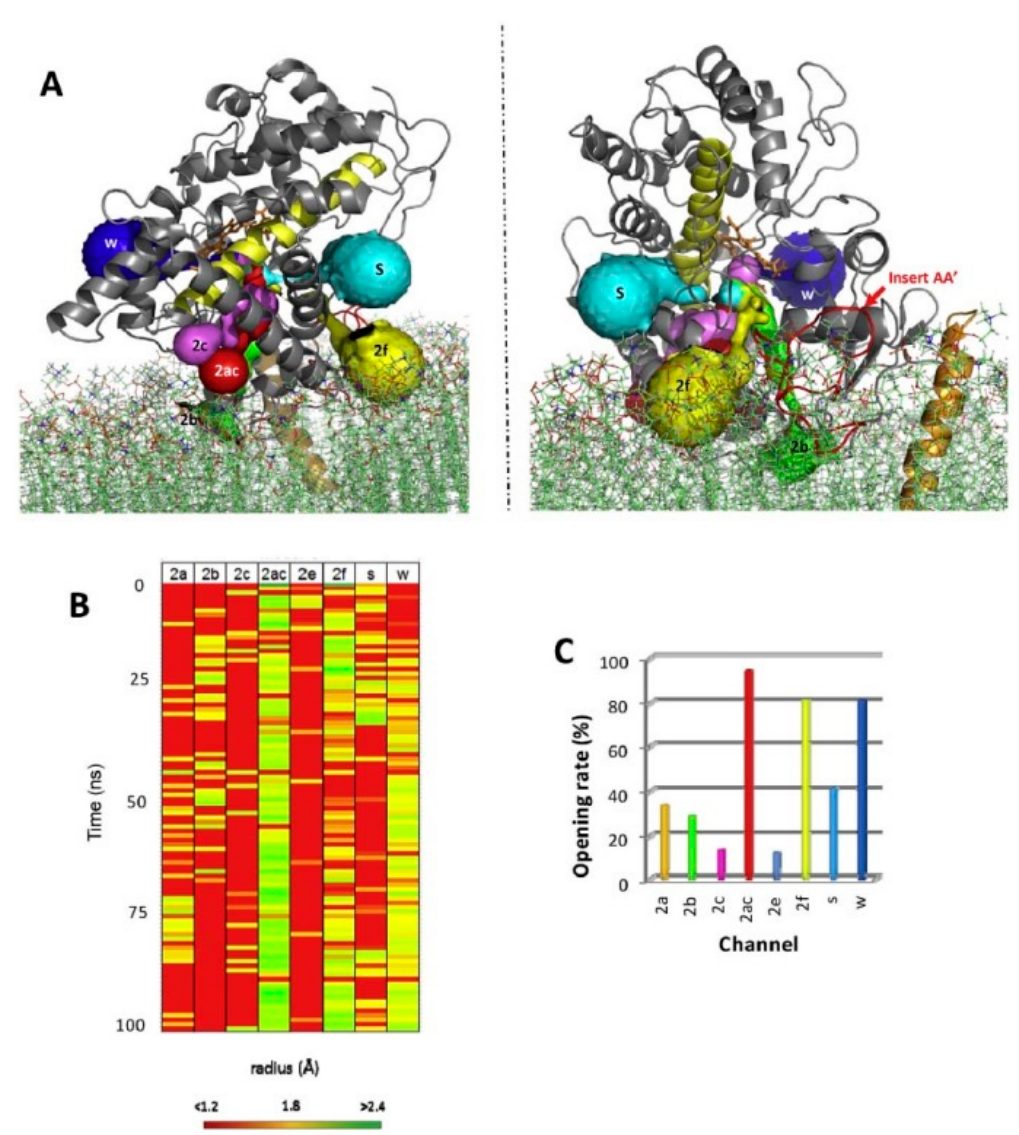
Figure 3. Channels dynamics in CYP2U1. ( A ) Representation of the CAVER channels labeled according to Wade et al. nomenclature [38]. The two figures are deduced from a 90° rotation. ( B ) Heatmap of the time course of opening and closing of channels during molecular dynamics simulations the color map ranges from red to yellow for closed channels (radius < 1.2 Å) and from yellow to green for open channels (radius > 2.4 Å). ( C ) The percentage of trajectory frames in which the identified channels are open (with a radius > 1.2 Å) is shown with the same color code used for channel as in panel A. Clearly, channel 2ac is the most frequently opened in this molecular dynamics simulation of CYP2U1. This illustration comes from Ducassou et al. [60].